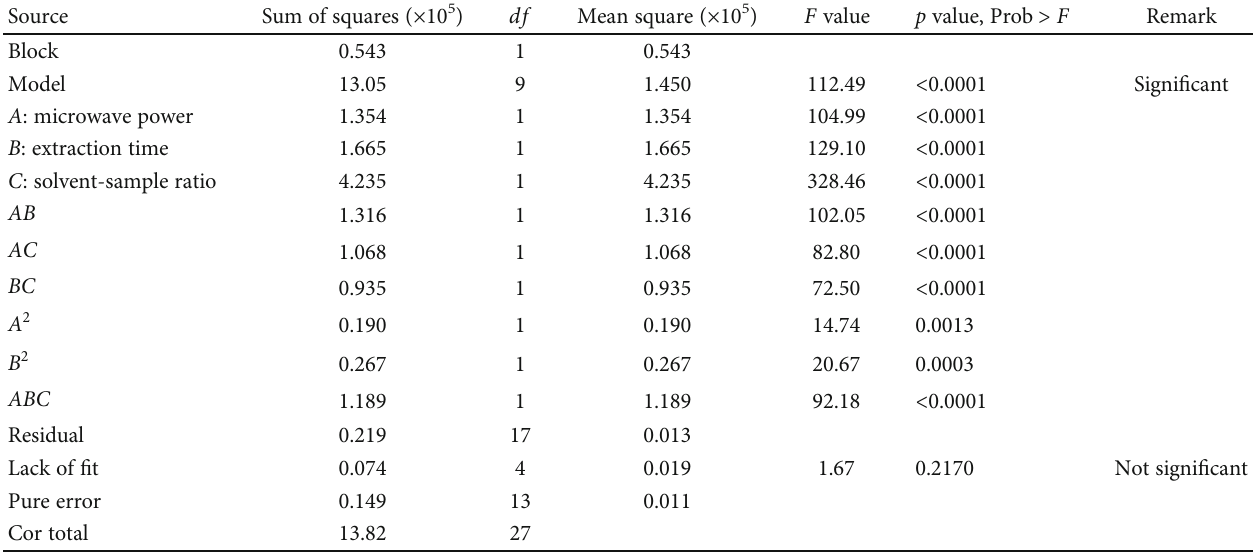
Table 5: Response surface reduced cubic model for the total carbohydrate content.